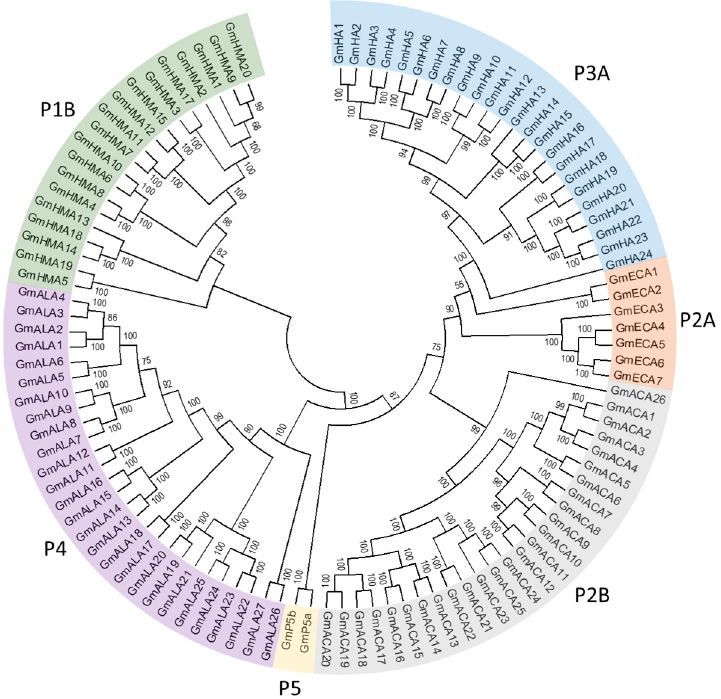
Figure 1. Phylogenetic tree of all P-type ATPase superfamily genes in the soybean genome: genes in the same subfamily are shaded by the same color.